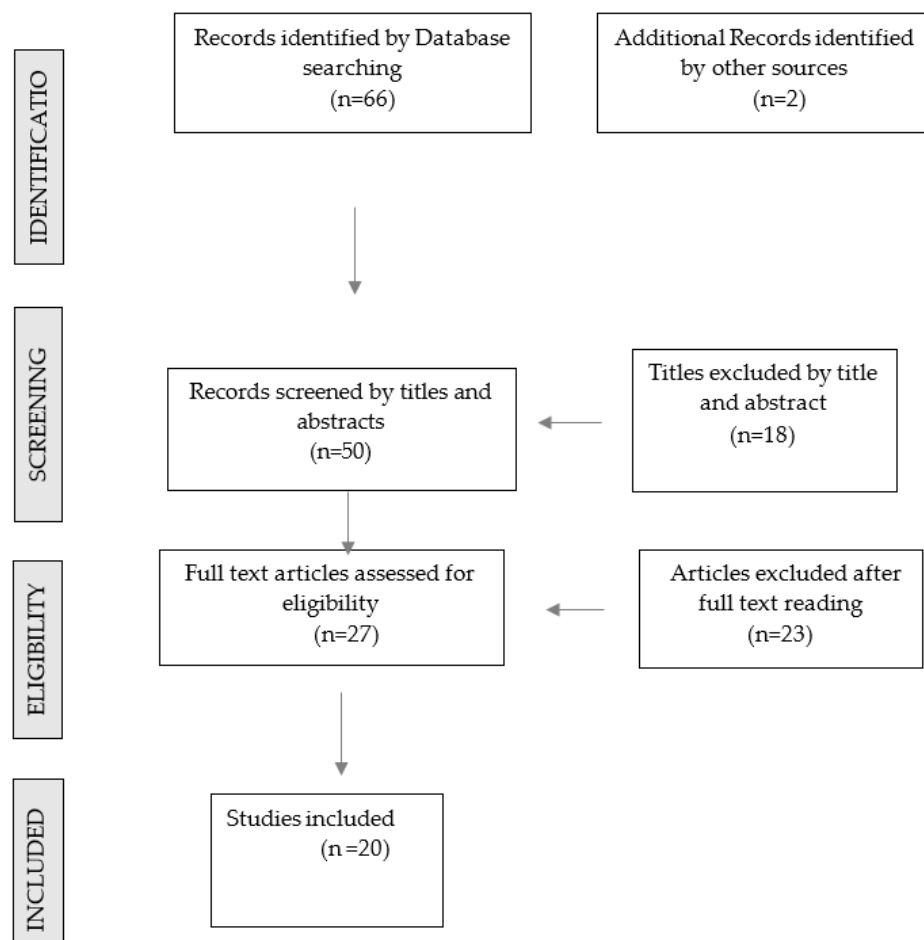
Figure 1. Flow chart presenting the screening of articles related to the mechanical behavior of different implant connections to be included in the review.